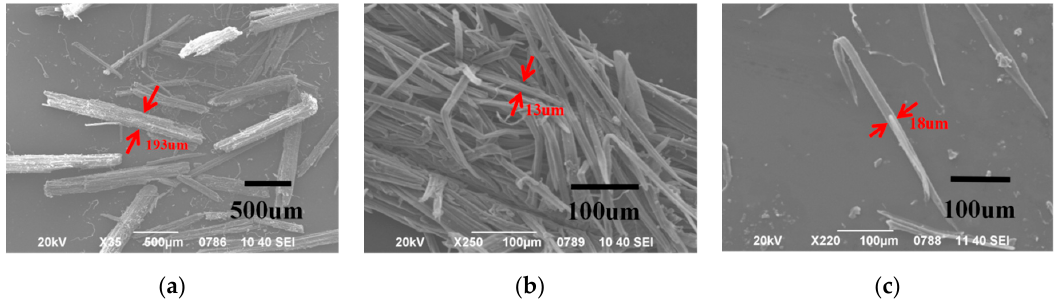
Figure 3. SEM images of ( a ) Artemisia vulgaris bast; ( b , c ) Artemisia vulgaris bast microcellulose fibers. Table 2. The length and diameter of micro- and nano-fibers.